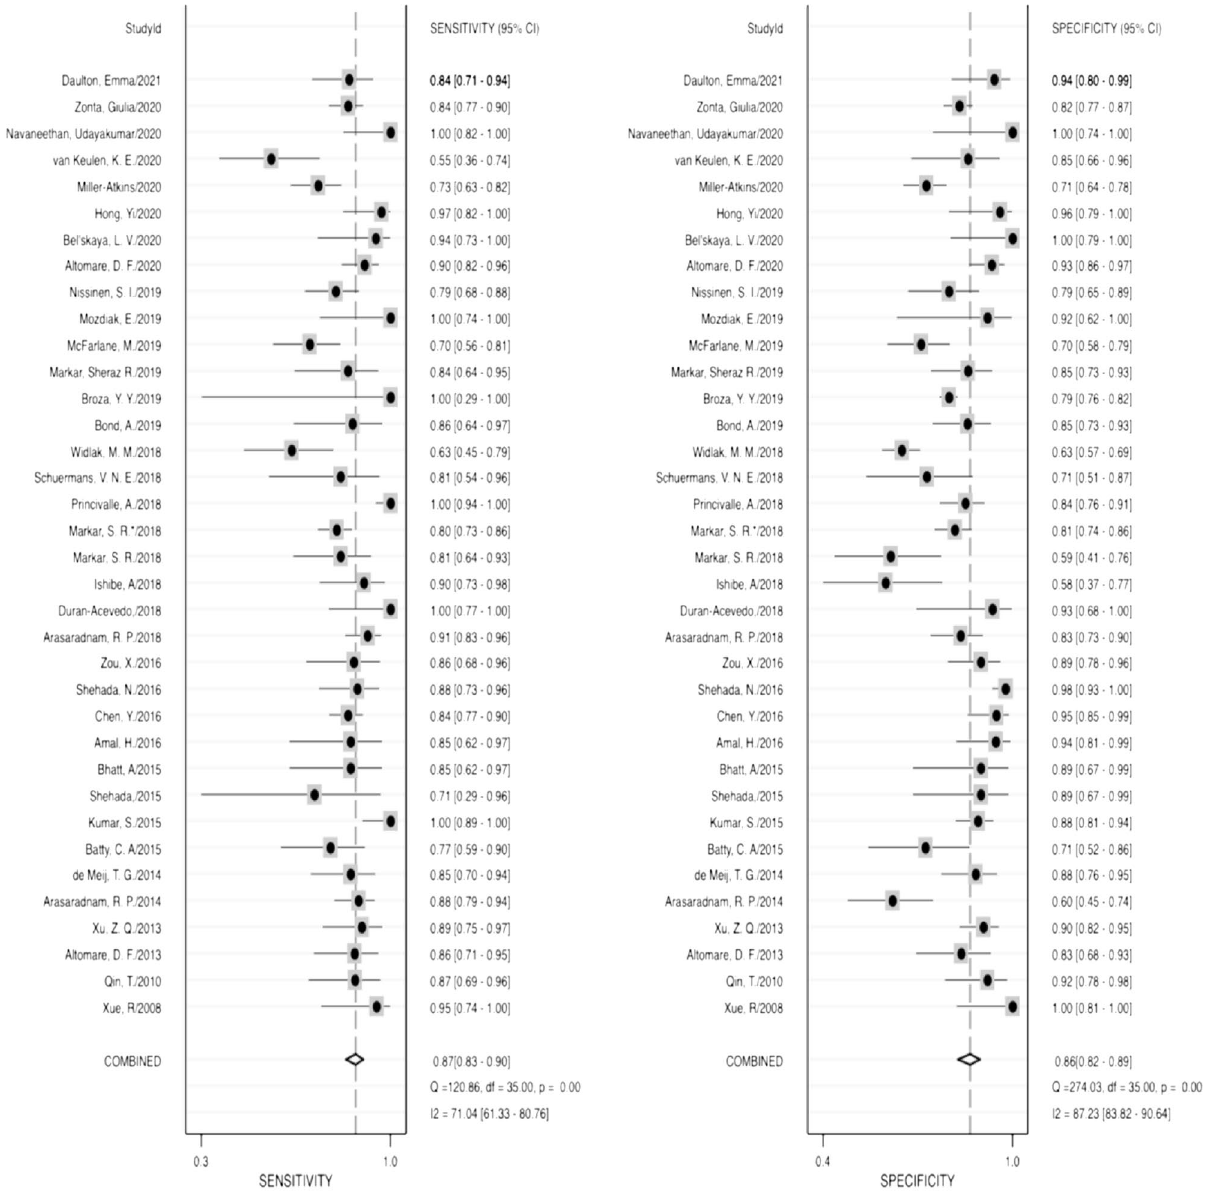
Figure 2. Forest plots of pooled sensitivity and